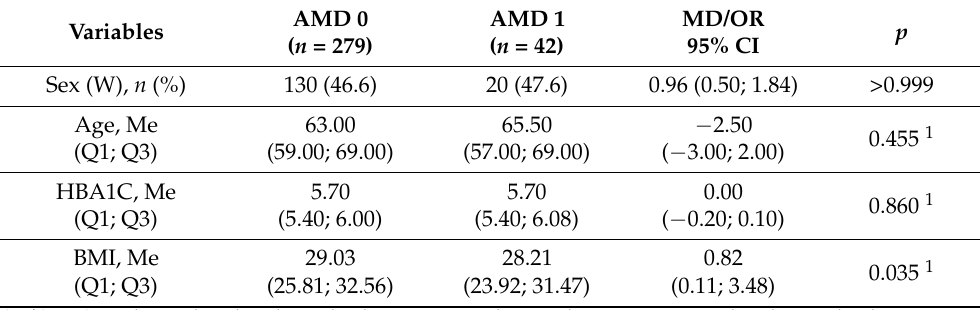
Table 2. Characteristics of patients with glucose disturbances by AMD diagnosis.